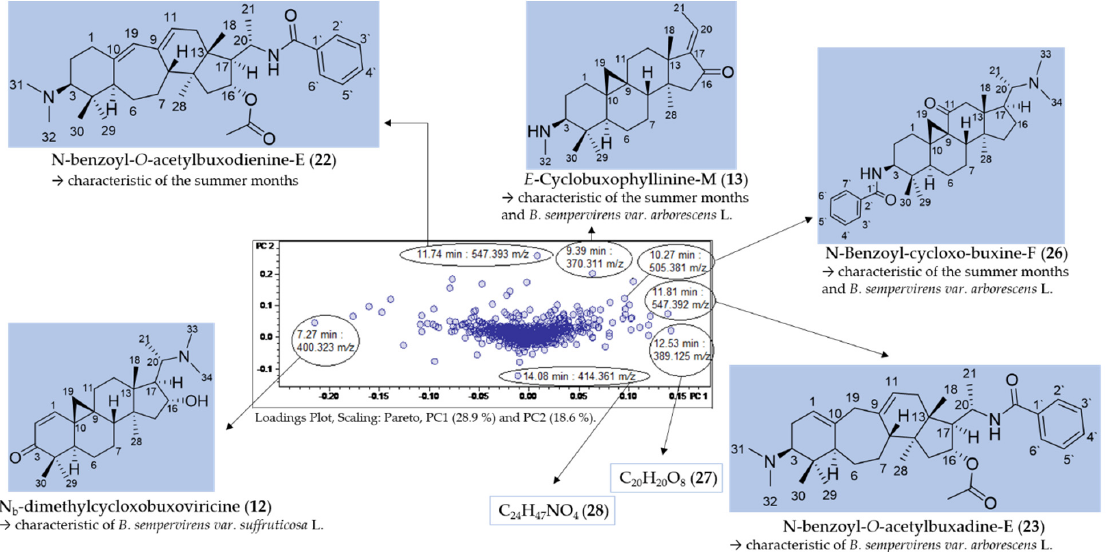
Figure 5. Assignment of buckets showing great variance in the loadings plot of PC2 vs. PC1 (compared with Figure 3B). Seven buckets were located in the periphery of the loadings plot (Figure 5) and were thus shown to represent major characteristic varietal and seasonal constituents. The chromatographic and mass spectral data of the LC/MS analysis of the compounds are listed in Table 2. Table 2. LC/MS-characteristics of compounds with great variance (compare Figure 5). Cmpd.